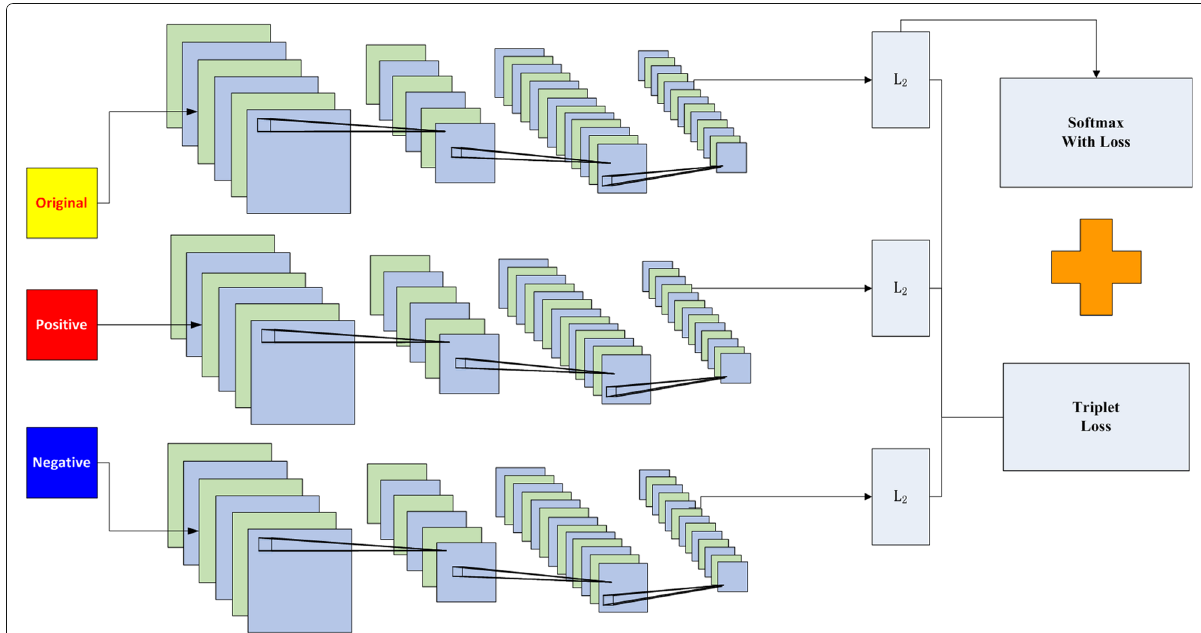
Fig. 5 The architecture of our proposed deep CNN. The proposed CNN takes the triple images as input (the original image, the positive image, and the negative image). Three parameter-sharing CNNs are exploited to process the original image, the positive image, and the negative image, respectively. Softmax loss and triplet loss are combined at the end of the architecture. L 2 denotes the L 2